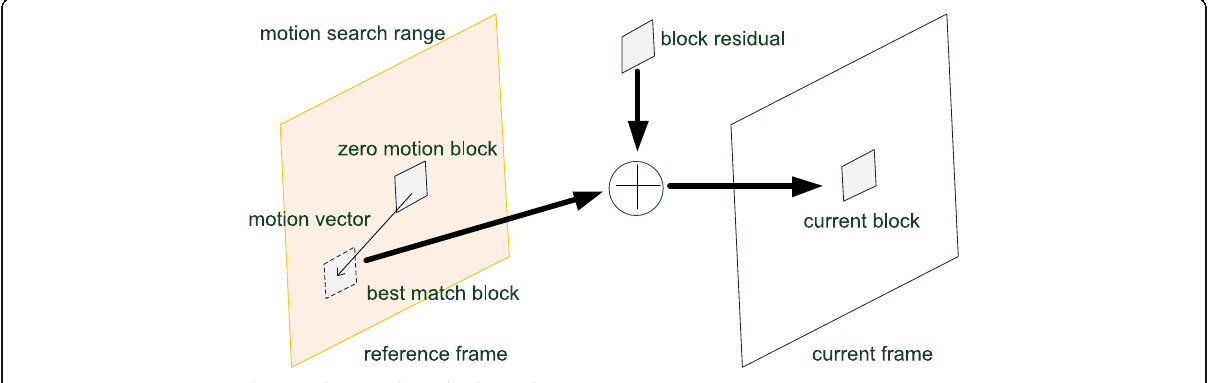
Fig. 2 Motion estimation at the encoder in traditional video